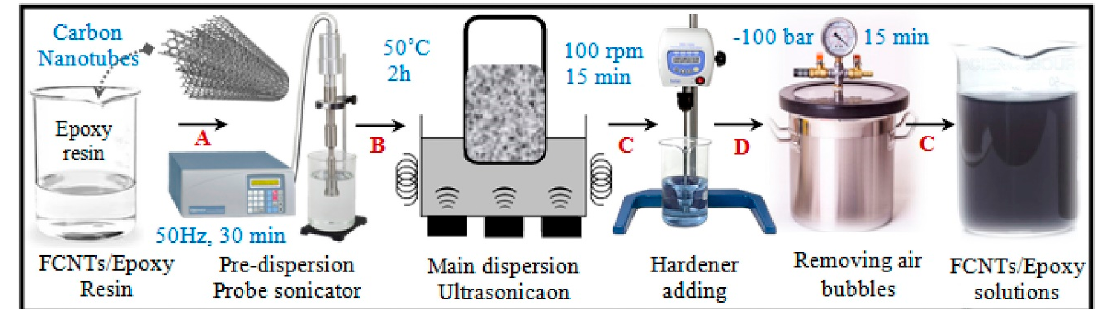
Figure 6. Example of preparation of a functionalized carbon nanotube / epoxy solution. Reprinted with permission [33].